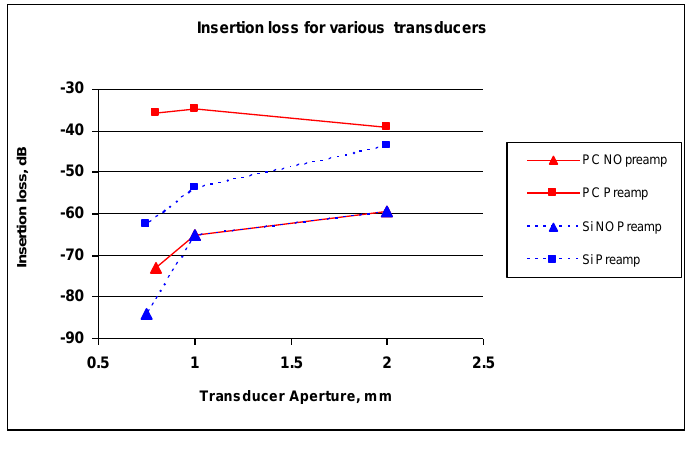
Figure 9. Insertion loss measurements of Silicon and Polycarbonate transducers with and without preamplifiers Insertion loss for various